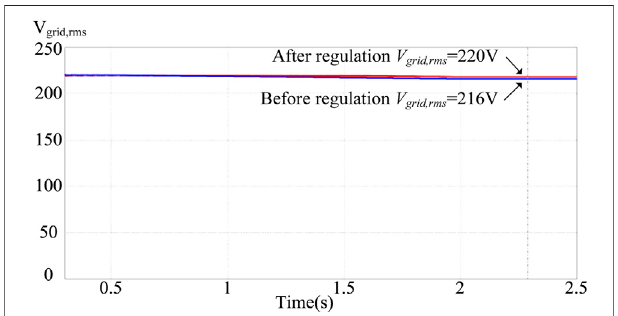
FIGURE14 | When thegrid voltage per unit value isbetween 0.97 and 1 p.u., the grid voltage value V grid without regulation and the grid voltage value V grid after regulation.